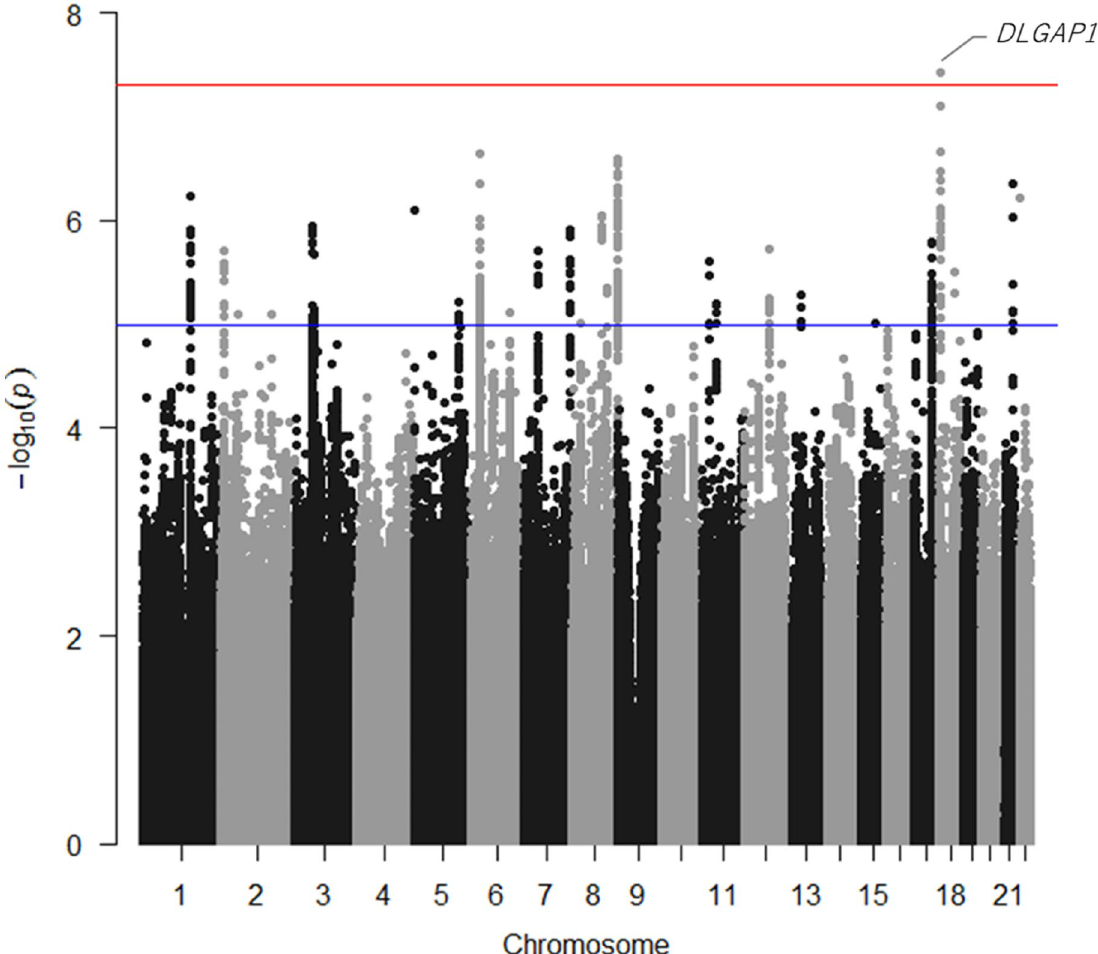
Figure 1. Manhattan plot for genome-wide association study (GWAS) of resistant hypertension in Japanese population. This plot is based on − log 10 ( P value) from GWAS and imputation analysis against chromosome position. Blue line indicates suggestive association threshold, P < 1 × 10 −5 ; red line indicates genome-wide significance threshold, P < 5 × 10 −8